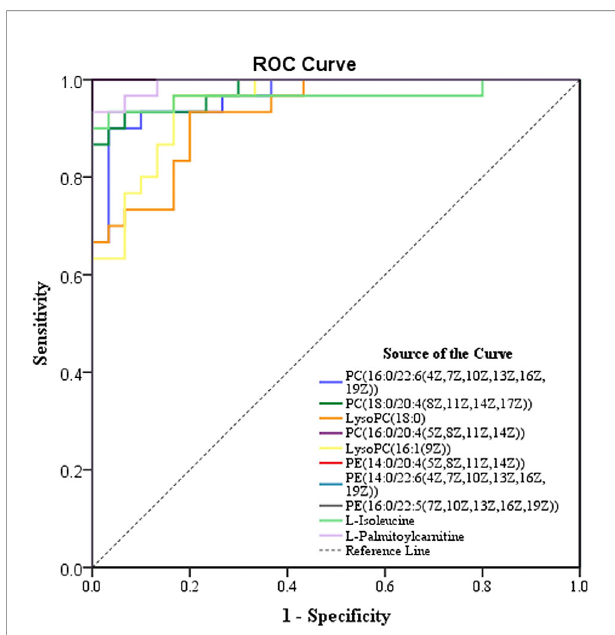
FIGURE 5 | ROC curve of nine metabolites in the diagnosis of lung